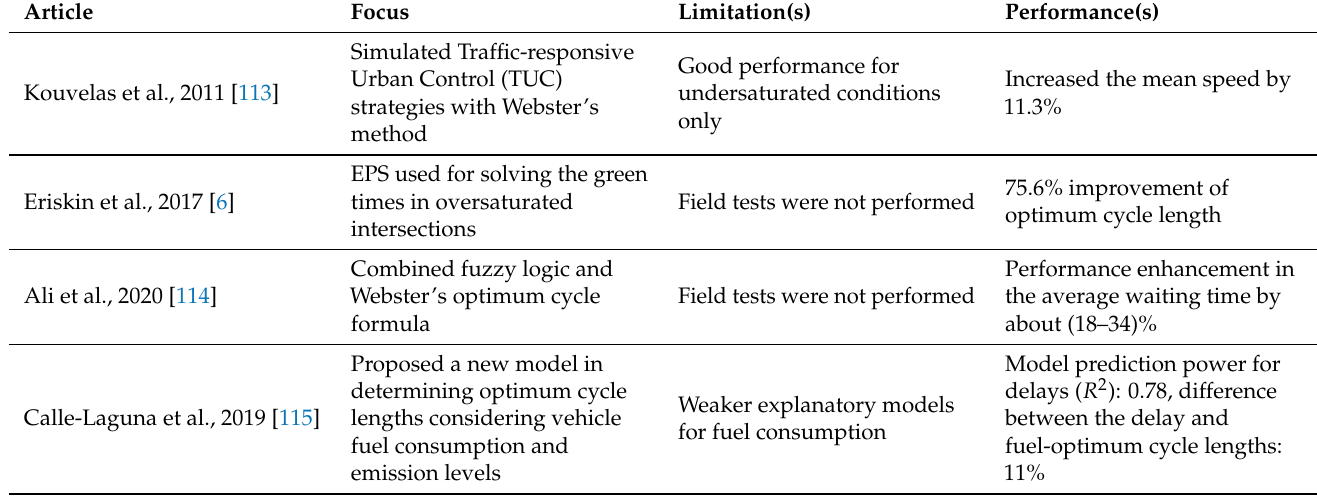
Table 18. Summary of the works found based on the Webster’s